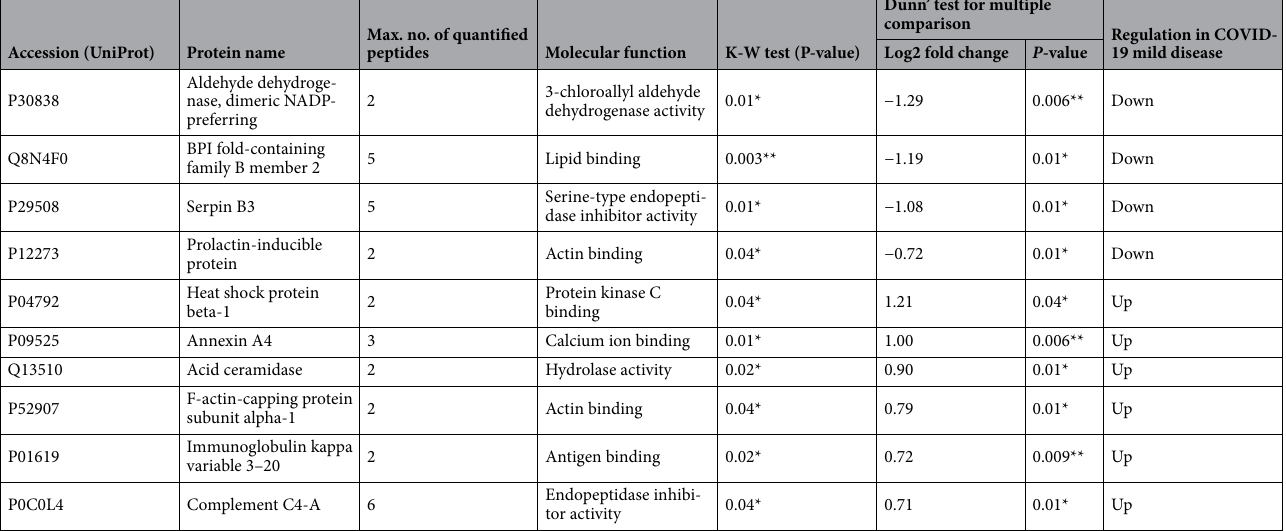
Table 2. Differentially expressed proteins in mild COVID-19 (n = 5) compared with healthy individuals (n = 10). K-W: